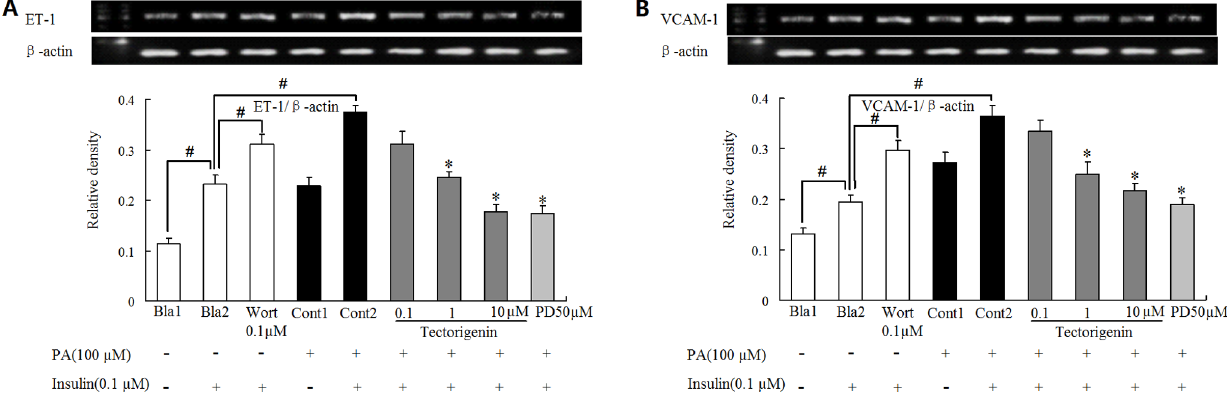
Figure 7. Tectorigenin reduced ET-1 and VCAM-1 expression in PA-stimulated endothelial cells. HUVECs were pretreated with tectorigenin, PD98059 or wortmannin (Wort) for 0.5 h and incubated with PA (100 m M) for another 2 h. Then cells were stimulated with or without insulin (0.1 m M) for 20 min. ET-1 (A) and VCAM-1 (B) mRNA expression was detected by RT-PCR. Salicylate was taken as a positive control. The results were expressed as the mean 6 SD of three independent experiments. # p , 0.05 vs. blank 2 (Bla2); * p , .05 vs. control 2 (Cont2).